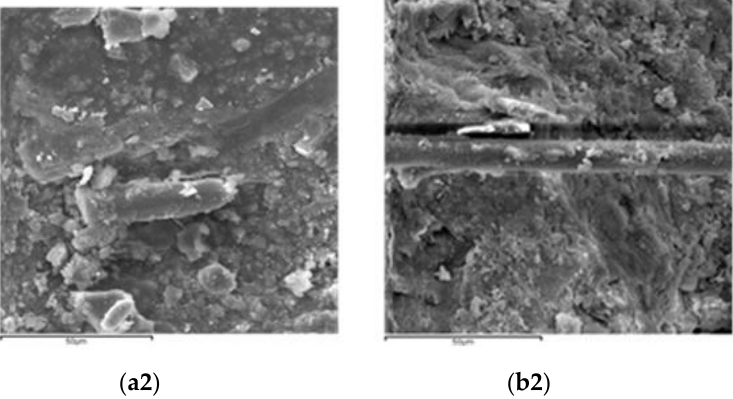
Figure 15. Effects of fire on FRC with 1.5% fiber content, ( a1 ) unfired FRC-1.5%PF, ( a2 ) FRC-1.5%PF after 120 min of fire, ( b1 ) unfired FRC-1.5%BF, ( b2 ) FRC-1.5%BF after 120 minutes of fire.